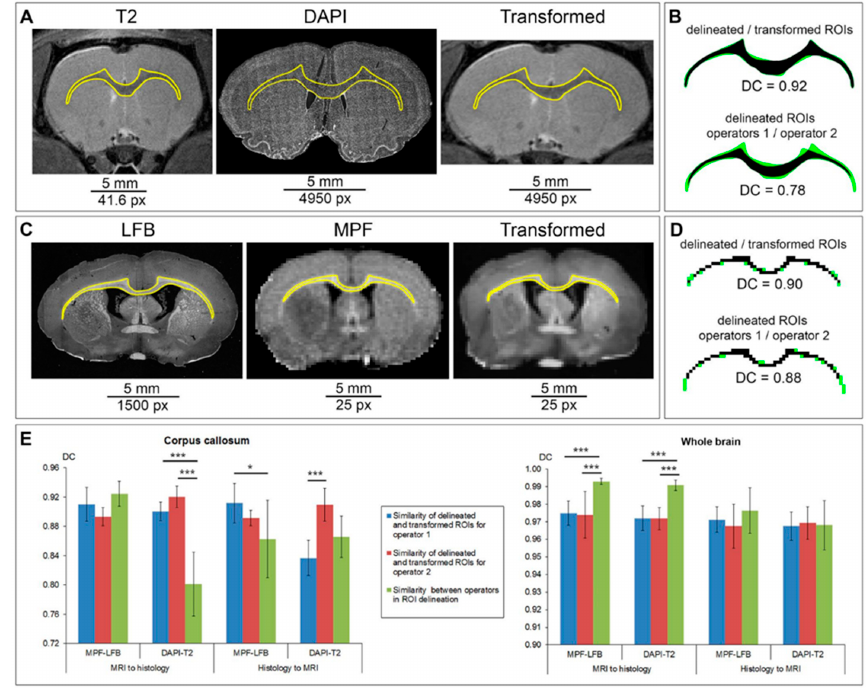
Figure 4. Correspondence between two operators in the manual delineation of the CC and brain section. ( A ) Examples of source MR and histology images from the LFB-MPF and DAPI-T2 datasets for manual delineation. The LFB image is presented as an inverted red channel of the source image. The grayscale DAPI image includes a magnified view of the delineated CC. ( B ) Correspondence of CC ROIs delineated in source images ( A ) by two operators with DC: black color represents matched pixels; green color represents mismatched pixels. ( C – E ) DCs of manual delineation of CC and brain section by two operators: dependence on the presence of an ischemic lesion ( C ), type of source image ( D ), and type of delineated structure ( E ). Error bars correspond to the SD. Significant differences: * p < 0.05, *** p < 0.001.